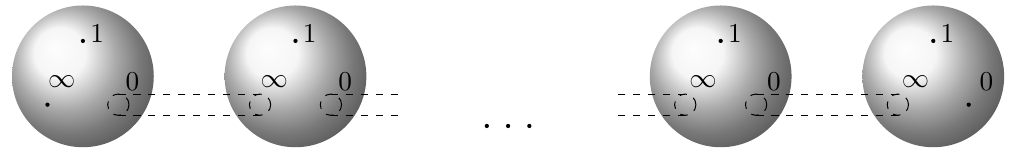
Figure 7 . The plumbing construction for the N -punctured sphere.